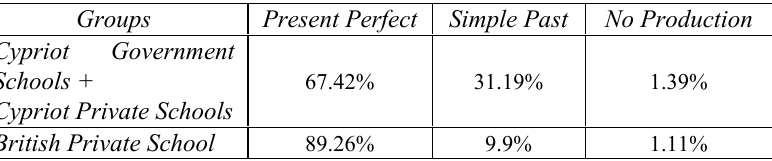
Table 4: Test performance by groups